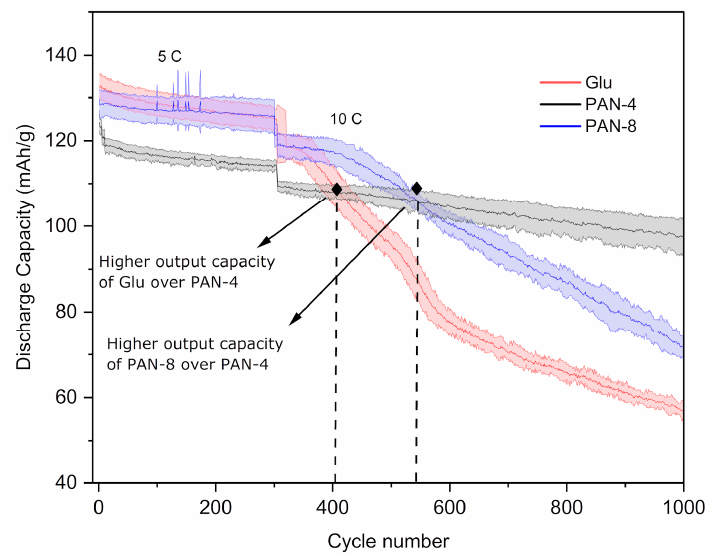
Figure 7. The comparison among PAN-4, PAN-8 and Glu samples stability at high current densities; the filled area corresponds to the standard deviation obtained from three coin-cells measurements.